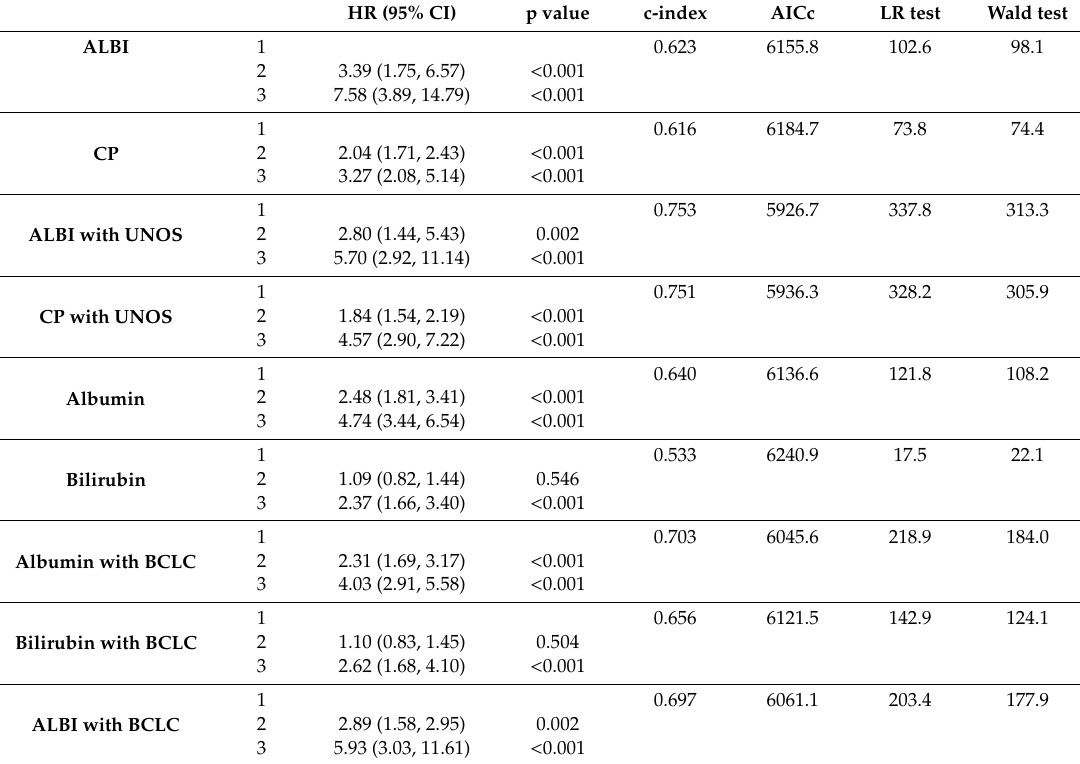
Table 4. Cox Proportional